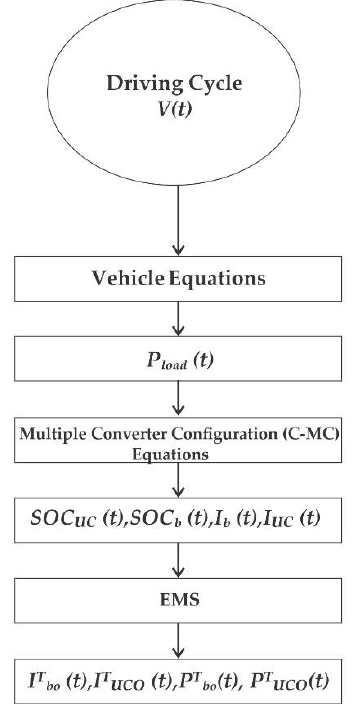
Figure 15. Flowchart to obtain the presented results.